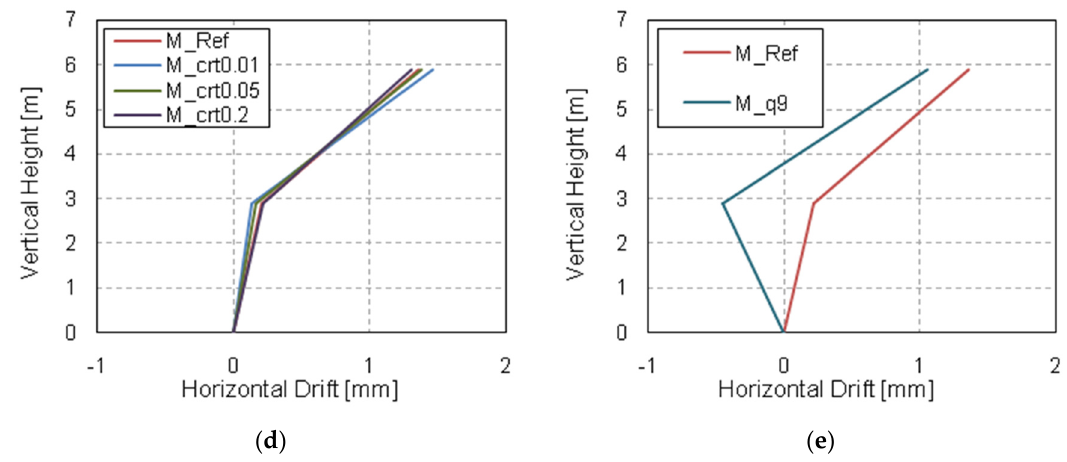
Figure 8. Numerical residual horizontal drift obtained by varying ( a ) concrete tensile strength, ( b ) flexural reinforcement ratio, ( c ) number of floors, ( d ) column removal time and ( e ) superimposed load. Table 6. Residual and peak horizontal drift values obtained in each floor for each model. Units in mm. Floor 1st Floor 2nd Floor Floor Model Model 1st Floor Peak